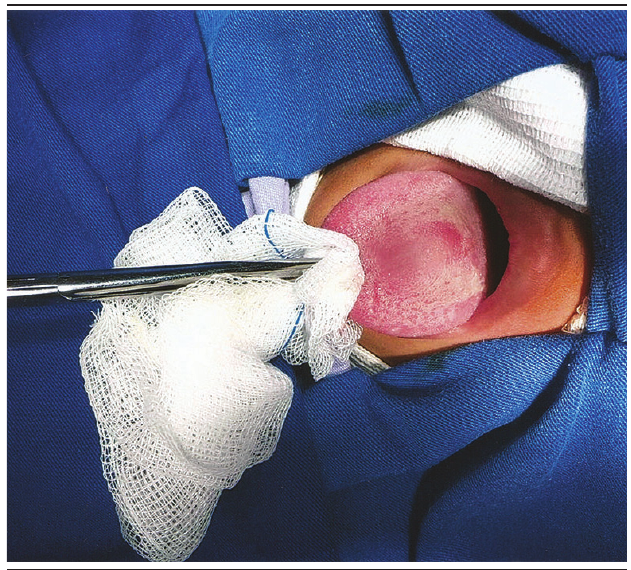
Figura 1 − Imagem da lesão antes do